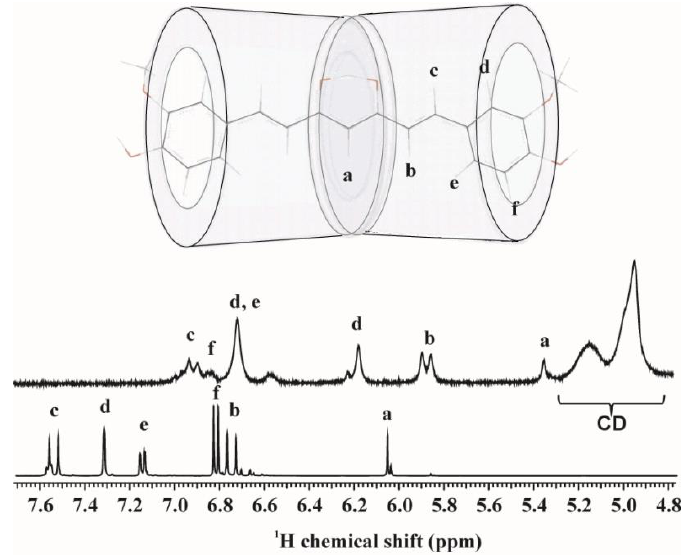
Figure 3. 1 H NMR of curcumin / HP- γ -CD complex in D 2 O (upper spectrum) and curcumin in DMSO-d 6 (lower spectrum). The schematic CD rings represents the proposed complex structure.